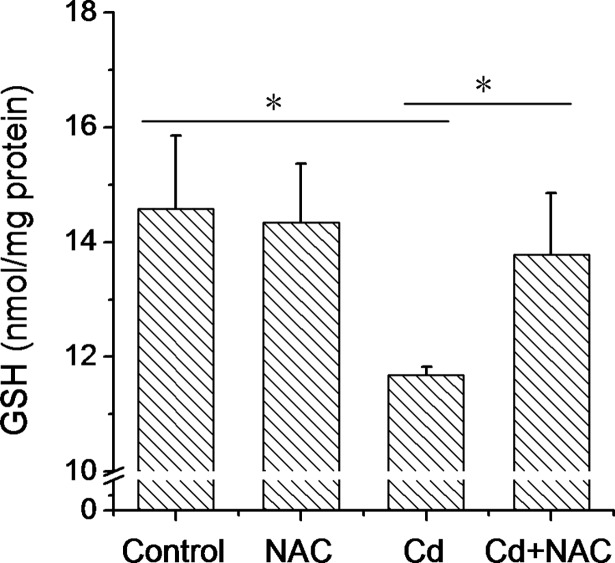
Effects of NAC on Cd-induced GSH depletion in mouse placenta.All pregnant mice except controls were i.p. injected with CdCl2 (1.0 mg/kg) daily from GD13 to GD17. In NAC+Cd group, pregnant mice were i.p. injected with NAC (1.0 g/kg) daily from GD12 to GD17, one dose (300 mg/kg) at 8 h before CdCl2 injection, one (400 mg/kg) at 30 min before CdCl2 injection, another (300 mg/kg) at 8 h after CdCl2 injection. Placentas were collected on GD 18. Placental GSH content was measured. All data were expressed as means ± SEM of six samples from six pregnant mice. * P<0.05.